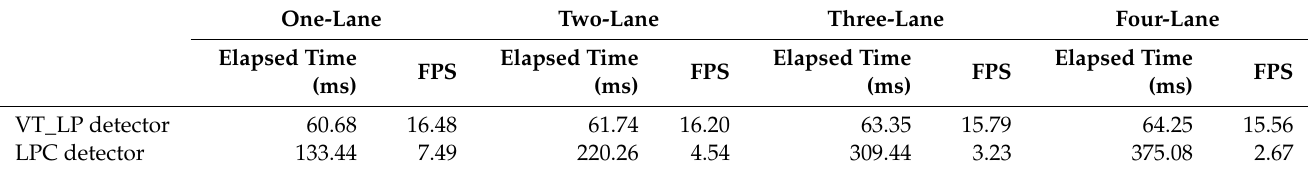
Table 7. Detection speed on Jetson AGX.